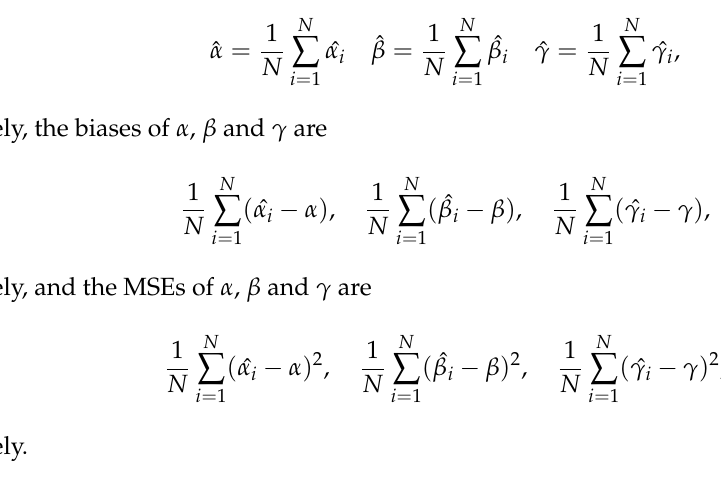
Table 2. Average maximum likelihood estimates (MLEs), biases and mean squared errors (MSEs) for α = 1.5, β = 5 and γ =